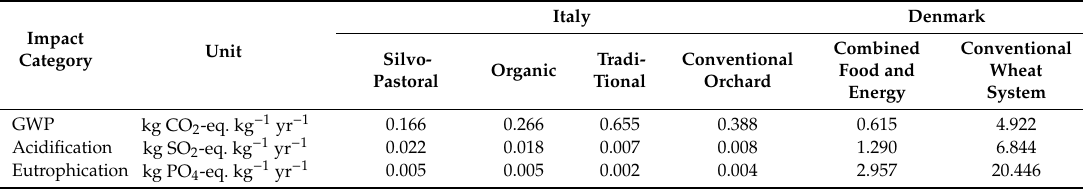
Table 2. Environmental impacts of the production systems. Greenhouse gas emissions from the Italian production systems are provided per weight (kg) of olive yield, while the unit of income ($) is used for the Danish production systems. GWP: global warming potential